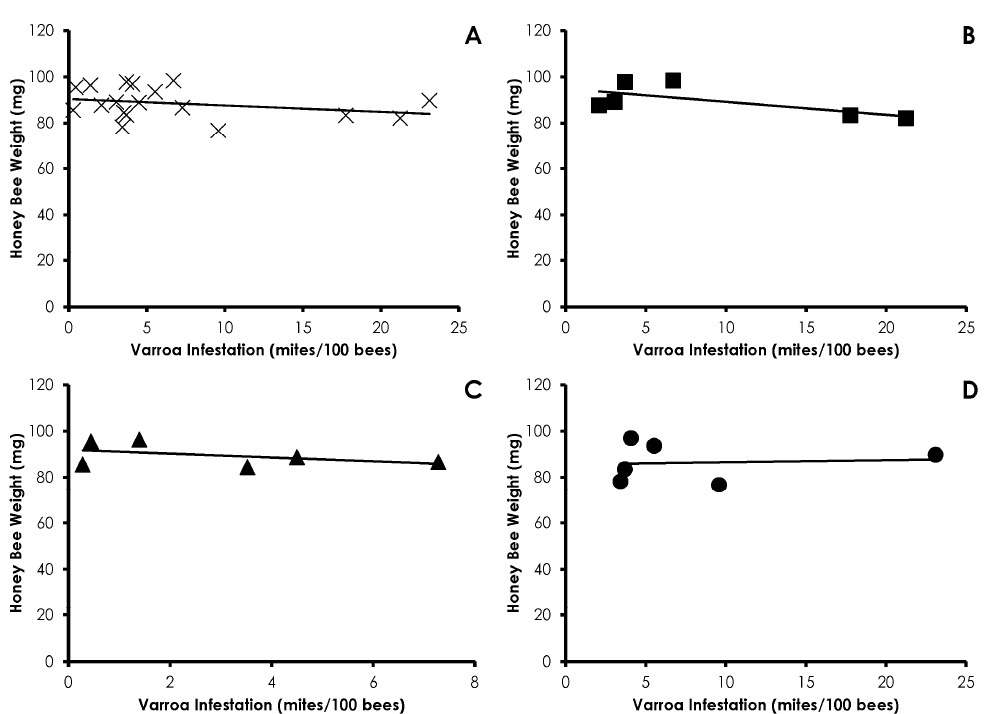
Figure 6. Influence of Varroa infestation on honey bee weight in all treatments ( A ); Control ( B ); Amitraz ( C ); and IPM ( D ) treatment groups. There was no significant effect of Varroa infestation on honey bee weight in any instance.